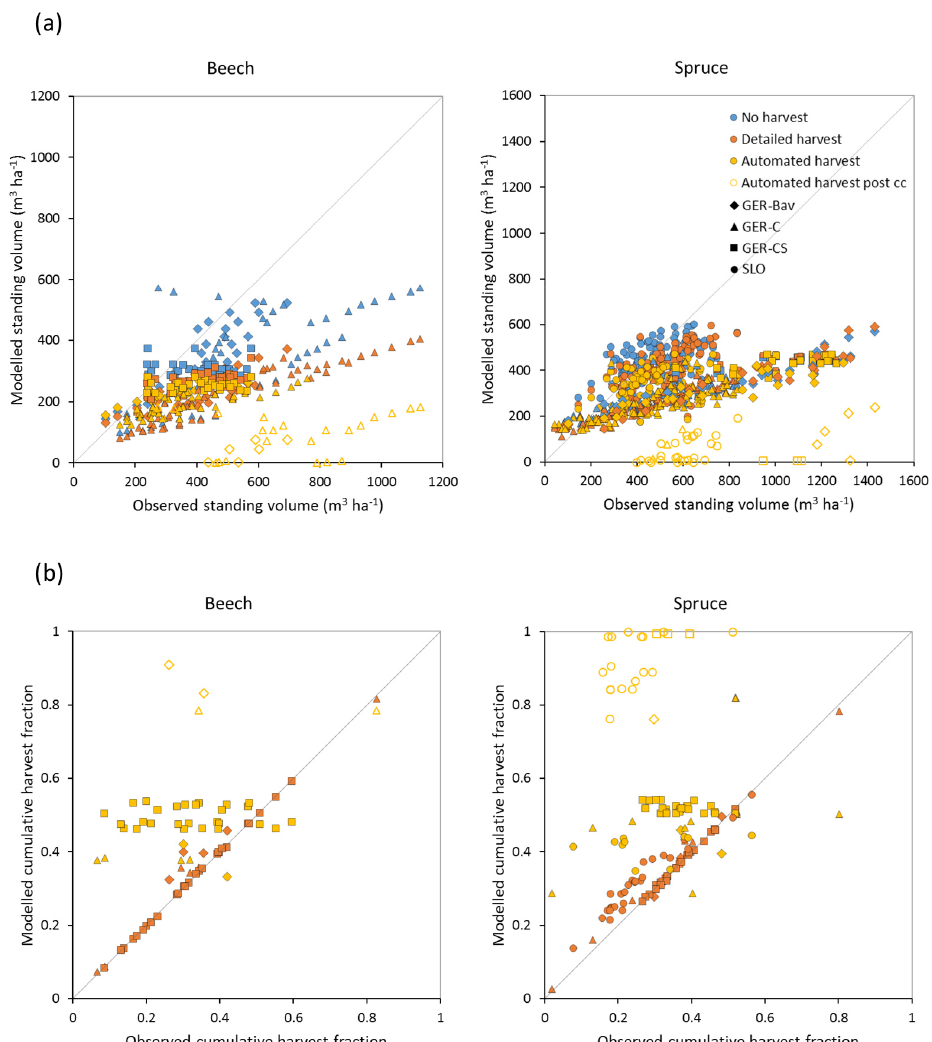
Figure 7. Modelled and observed standing volume (a) and cumulative harvest fraction during the measurement period (b) for European beech and Norway spruce stands in Germany (Bavaria: GER-Bav; central Germany: GER-C; central and southern Germany: GER-CS) and Slovenia (SLO). Simulations were performed without harvest, with detailed harvest, and with automated thinning and clear-cutting. Data points from the automated harvest simulation after clear-cutting occurred are plotted with unfilled symbols (automated harvest post